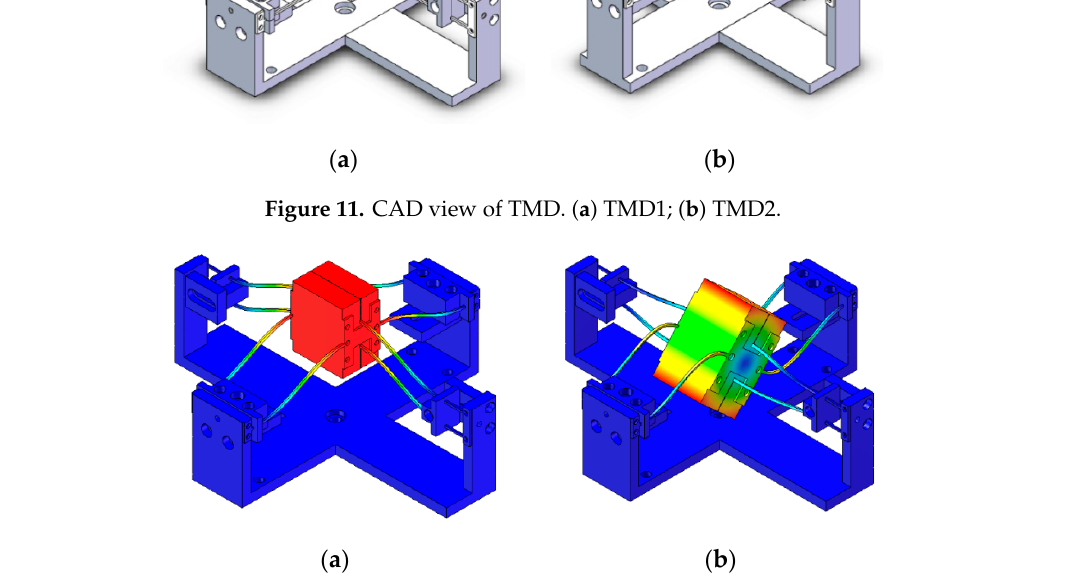
Figure 12. Mode shapes of TMD1. ( a ) The 1st mode; ( b ) the 2nd mode.